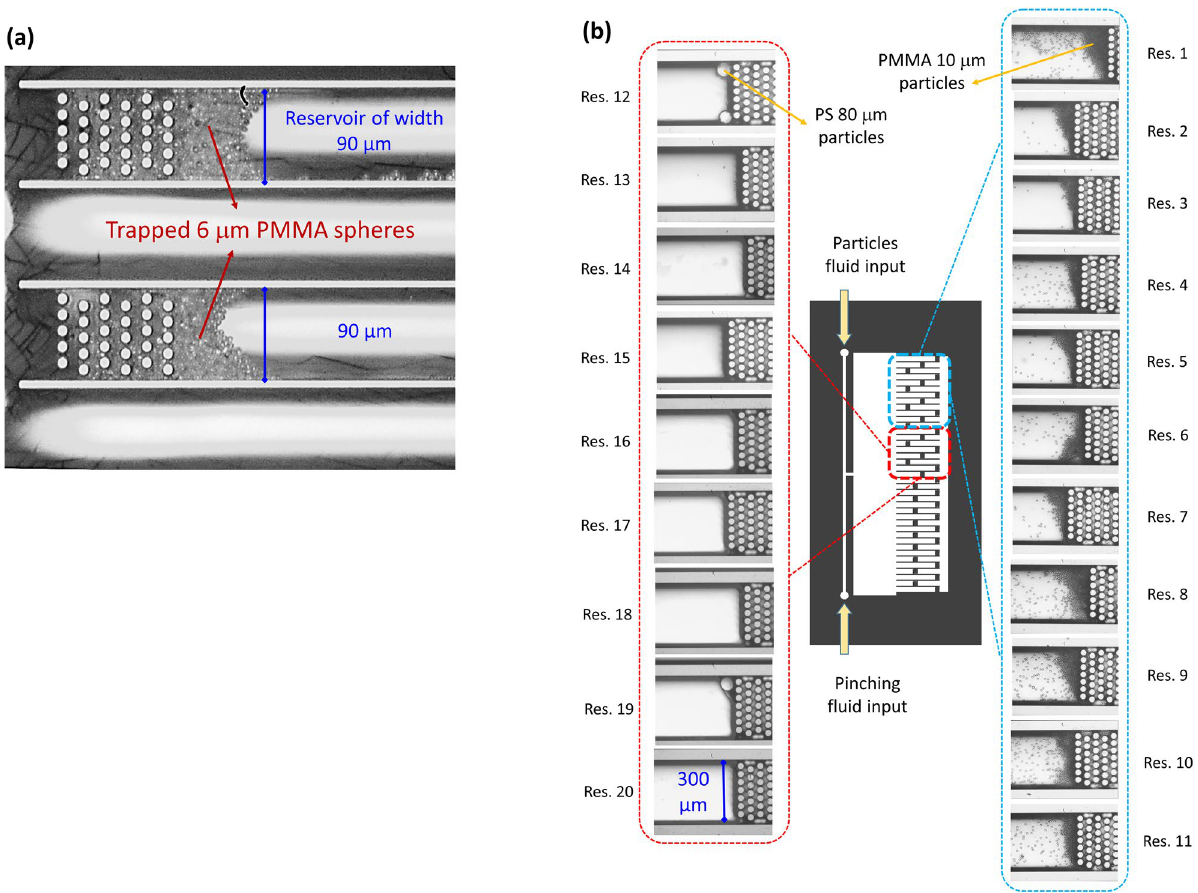
Figure 4. Particle trapping and sorting on-chip. ( a ) Trapping of monodisperse population of particles, consisting of standard PMMA particles of diameter 6 µm. ( b ) Sorting and trapping of polydisperse population (PMMA 10 µm and PS 80 µm standard particles) into multiple different